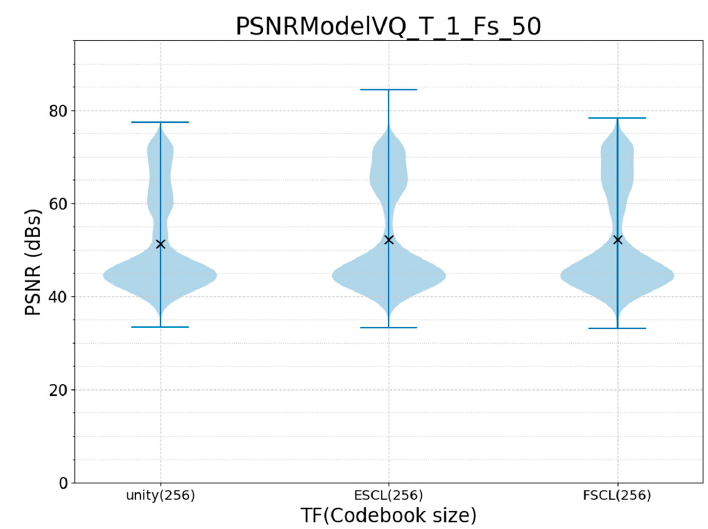
Figure 13. PSNR distribution and mean value (x) vs. the target function (F = 50 Hz, T = 1 s, N = 256). Table 4. Results for generalising the embedded codification.